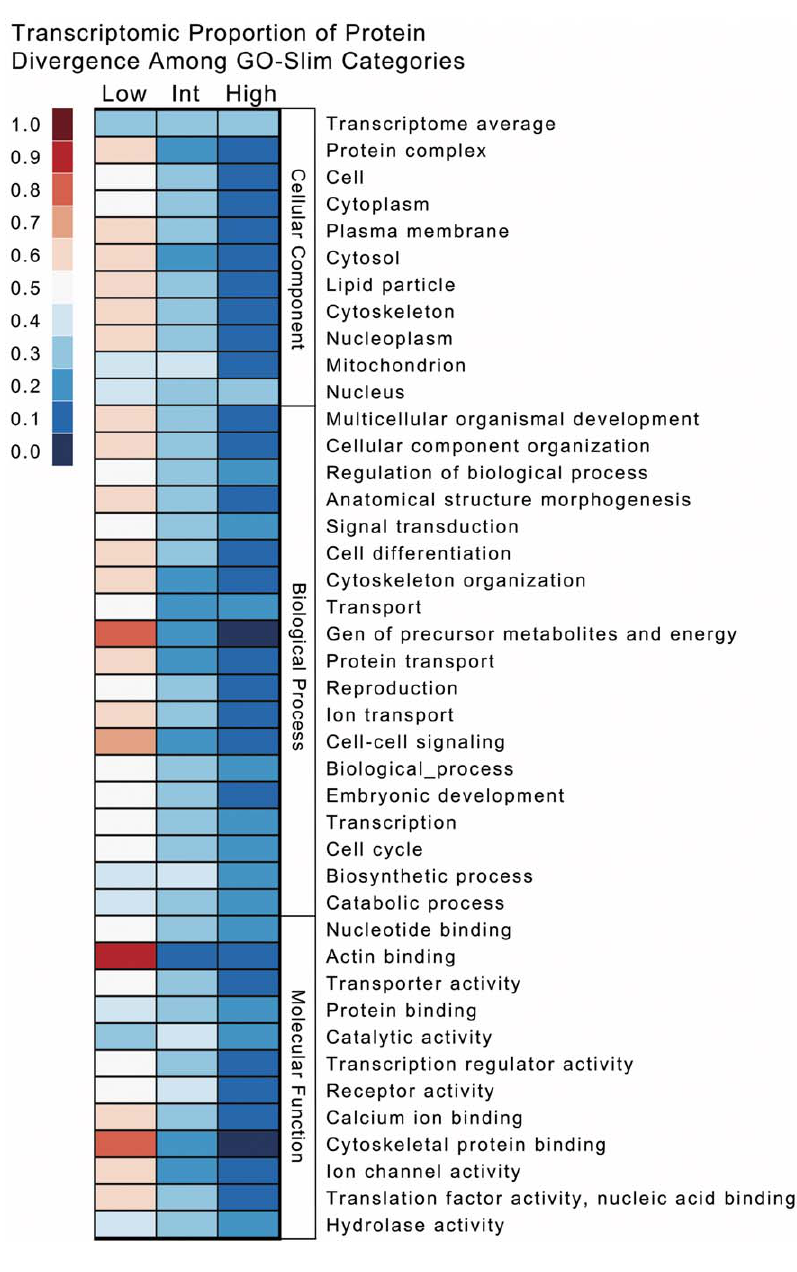
Figure 5. PROTEIN DIVERGENCE is unevenly distributed among GO-Slim categories. The heatplot shows proportion of 1:1 orthologous pairs exhibiting Low, Intermediate and High protein divergence in GO-Slim functional categories. Protein divergence was estimated as the proportion of aligned amino acids that differed between the two orthologues and each orthologous pair was categorized as Low, Intermediate or High (Materials and Methods). Only categories whose proportion of each bin differed from expectations based on all orthologous pairs with a p value less than the Bonferroni-adjusted a of 5.26 6 10 2 4 are presented. The average expected proportions based on all orthologous pairs are presented at the top of the